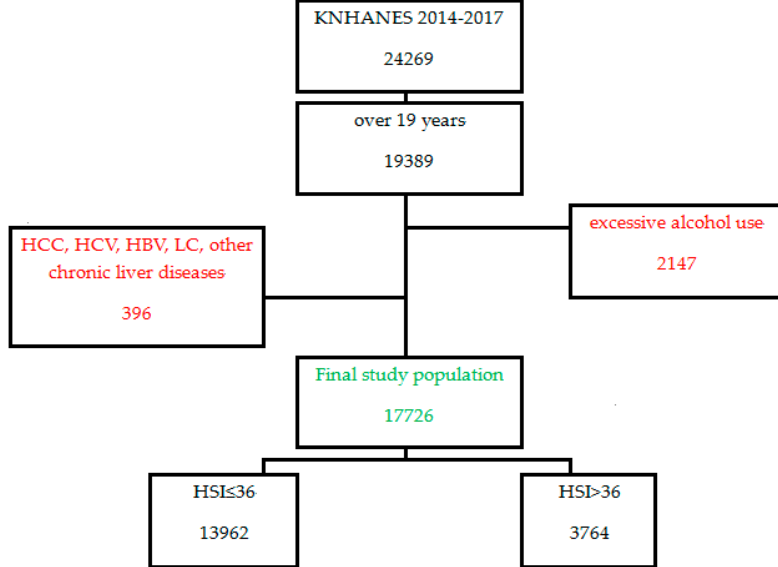
Figure 1. Flow diagram of subjects recruited in this study. HCC, hepatic cellular carcinoma; HCV, hepatitis virus C; HBV, hepatitis virus B; LC, liver cirrhosis; HSI, hepatic steatosis index; KNHNES, Korea National Health and Nutrition Examination Survey.